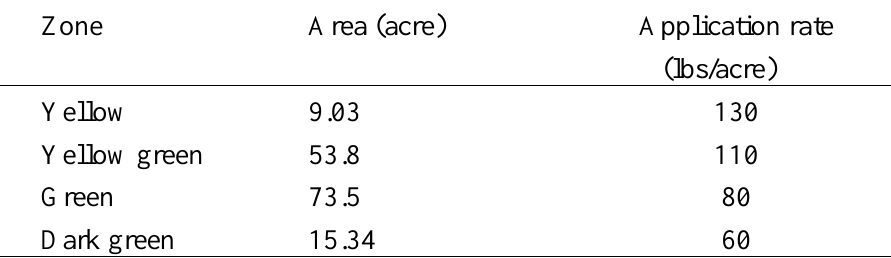
Table 1. Application rates of N fertilizer for the field shown in Figure 5.